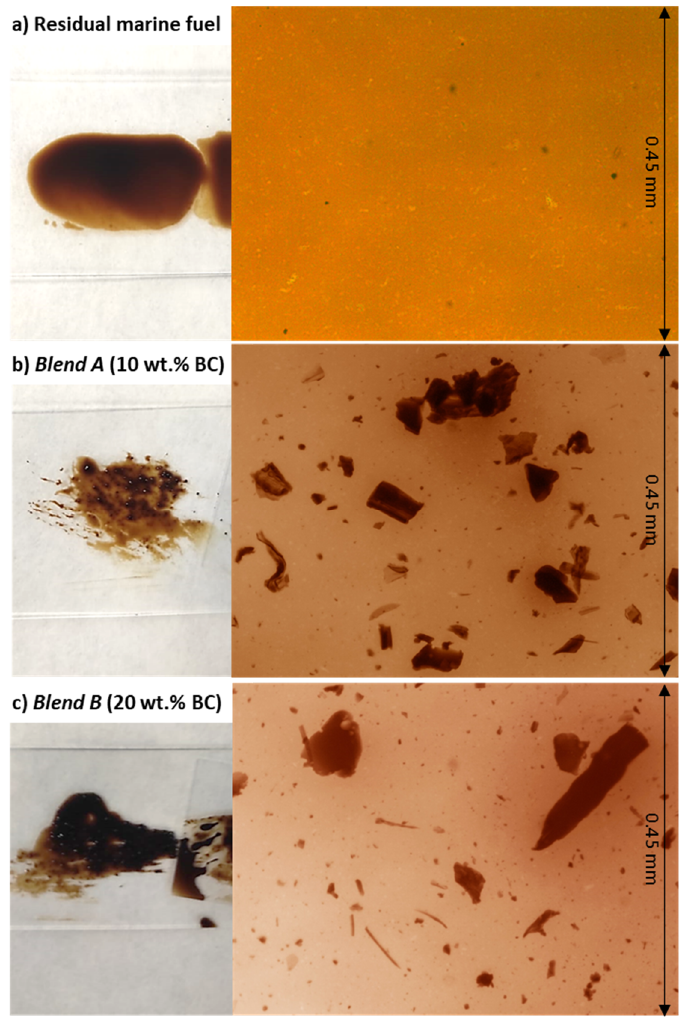
Figure 3. Images obtained with optical microscope at 10x magnification of: ( a ) MF, ( b ) Blend A, ( c ) Blend B (BC = biocrude from HTL of SS).